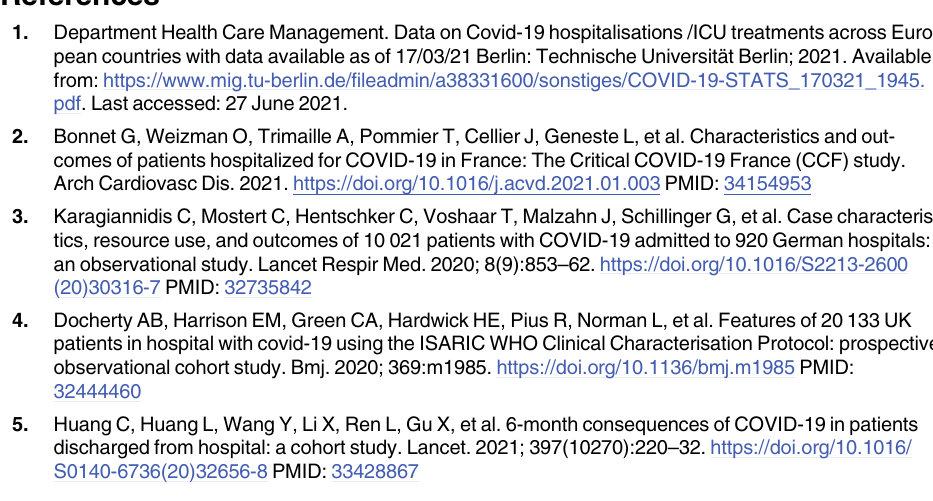
S1 Table. Diagnosis codes of included patients. S2 Table. Patient characteristics stratified by ventilation